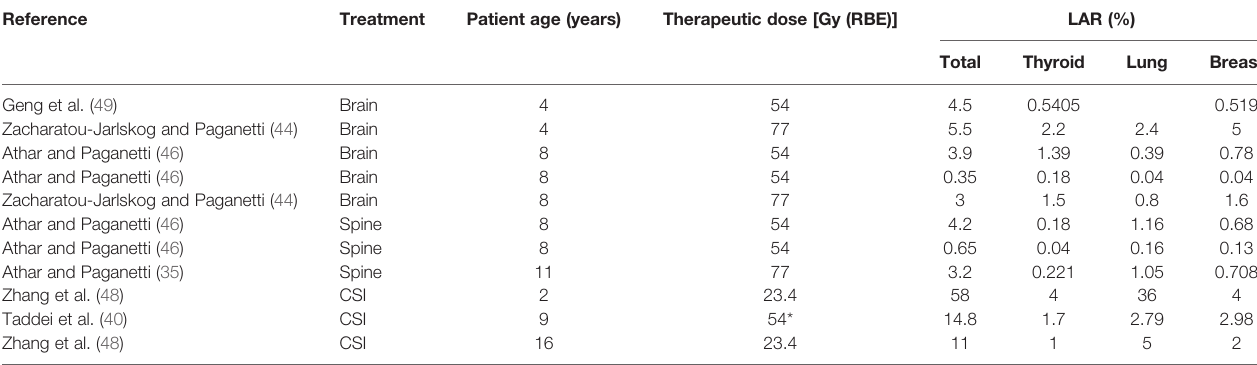
TABLE 2 | LAR in thyroid, lung, and breast together with the total LAR for several irradiations in female patients at different